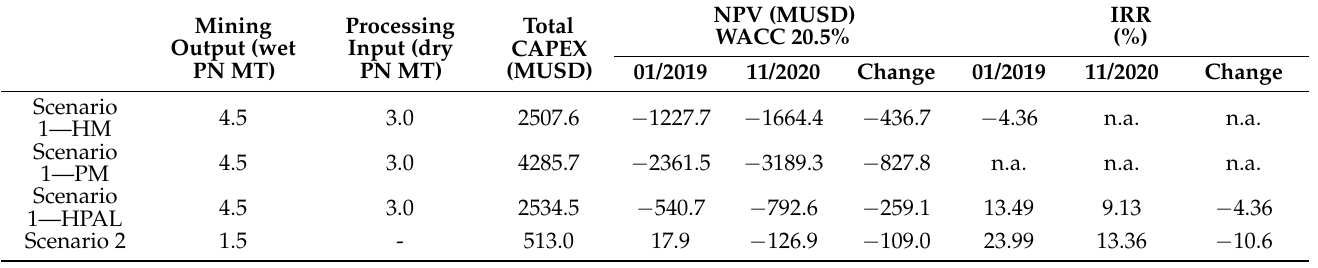
Table 13. Comparison of alternative project implementation scenarios.